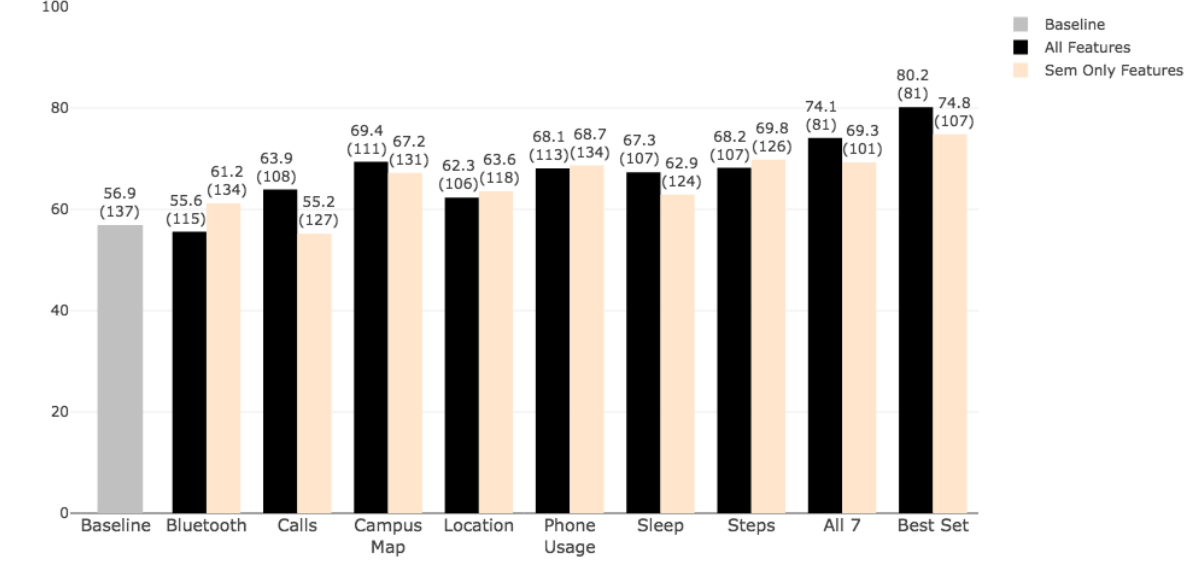
Figure 6. Detection of postloneliness level (high loneliness or low loneliness) using all-epochs features and semester-level features. Each bar shows the accuracy followed by the number of samples used in the analysis in parentheses; the gray bar represents the baseline accuracy as measured by the percentage of samples belonging to the majority class here, that is, high loneliness. Sem: